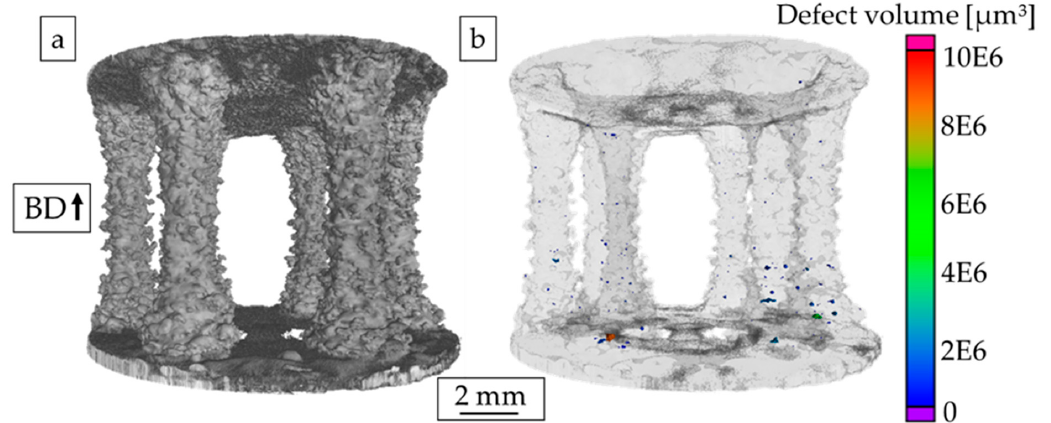
Figure 6. ( a ) Reconstructed µ -CT-volume and ( b ) pore distribution within the struts of one specimen (strut diameter of 2 mm).